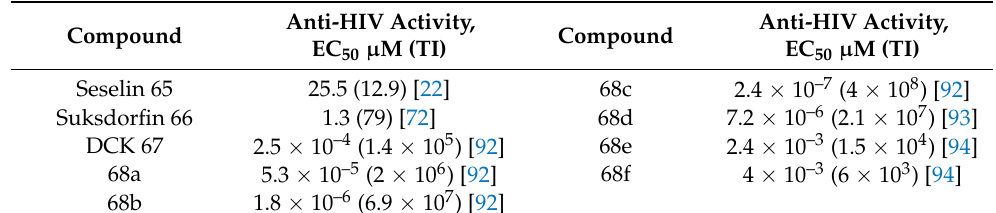
Table 6. Anti-HIV activity of suksdorfin and DCK analogs in H9 cells. Compound Anti-HIV Activity, Compound